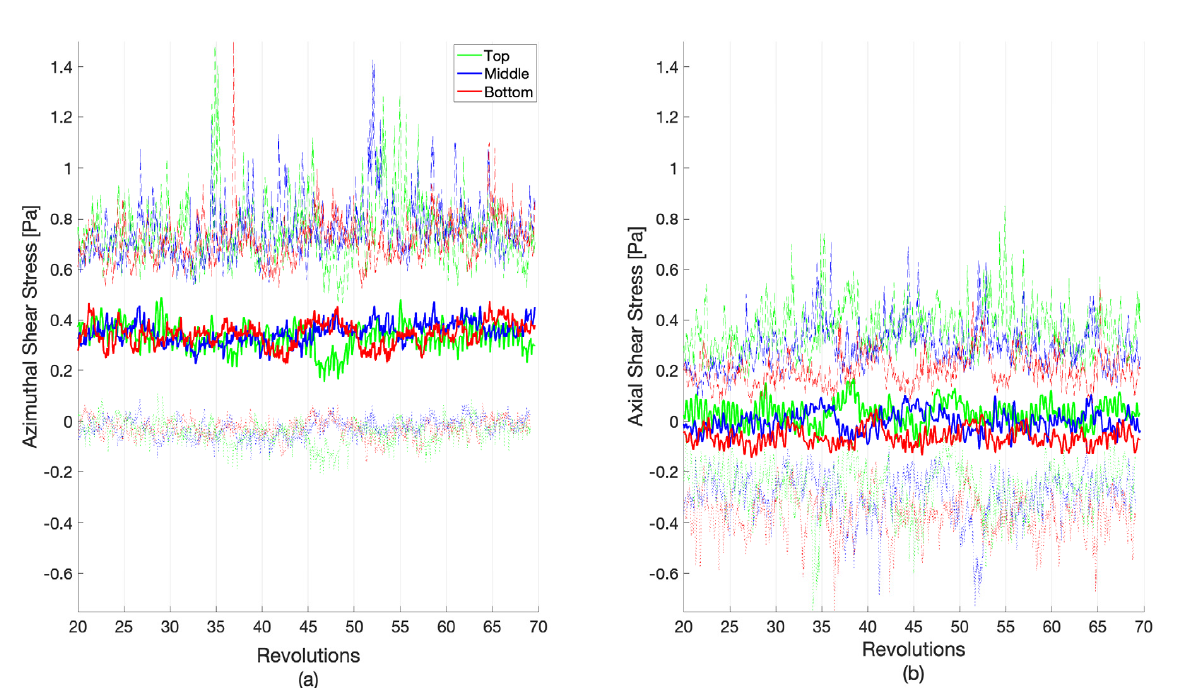
Figure 6. The ( a ) azimuthal and ( b ) axial vector components of the row-averaged shear stress between revolutions 20 and 70. The coupon averages (bold), maximums (dashed), and minimums (dotted) are shown. The average shear stress is area weighted by the element area.